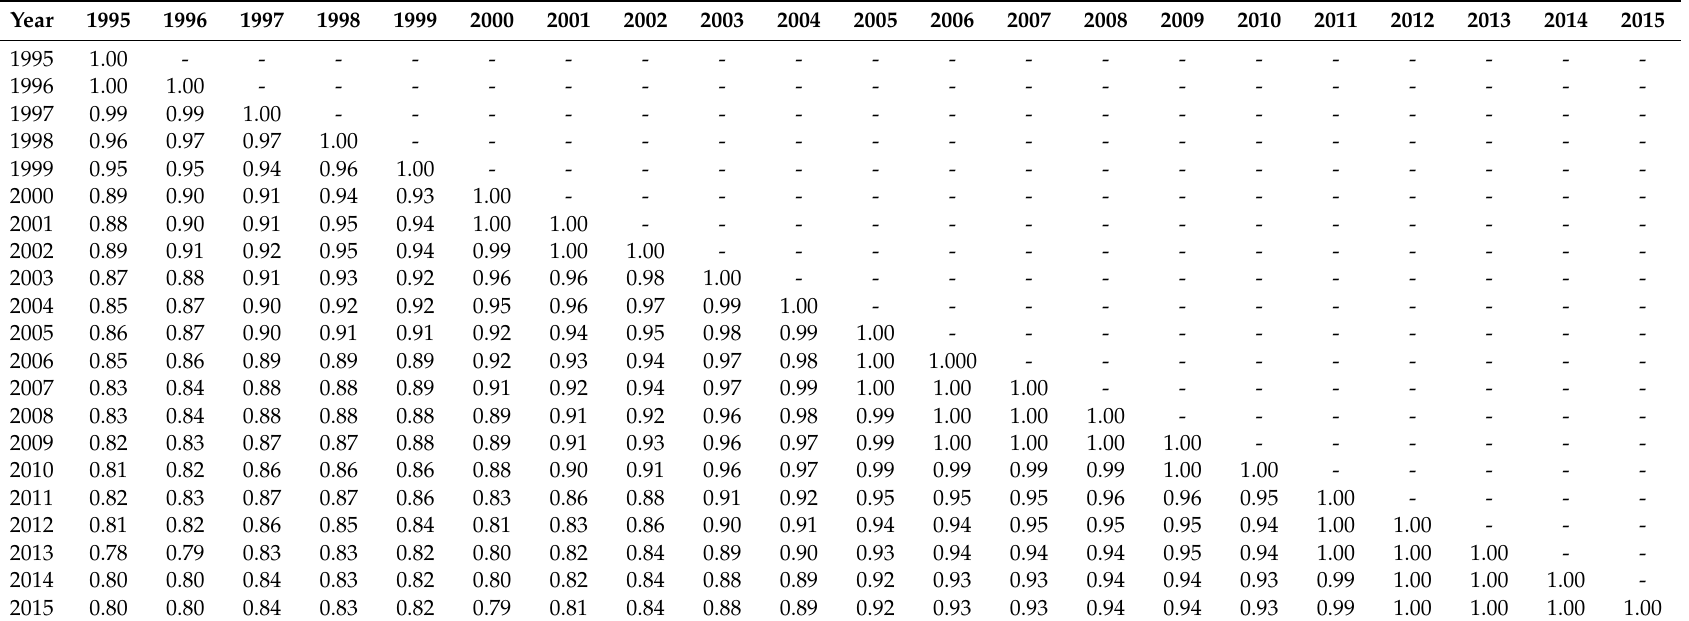
Table 3. Correlation coe ffi cients of annual SO 2